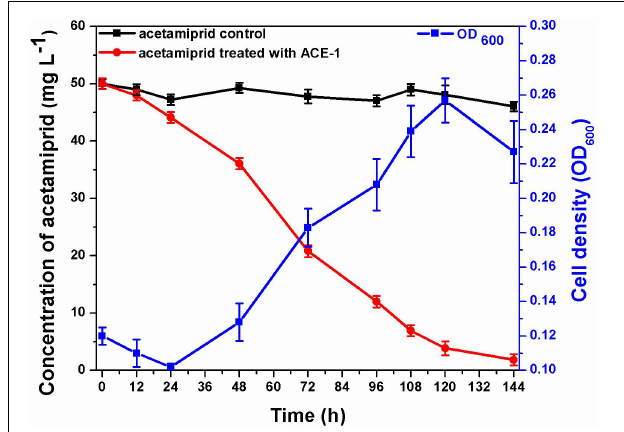
FIGURE 1 | Degradation of acetamiprid by consortium ACE-3 and the corresponding growth curves. The data represent the means ± standard deviations of biological